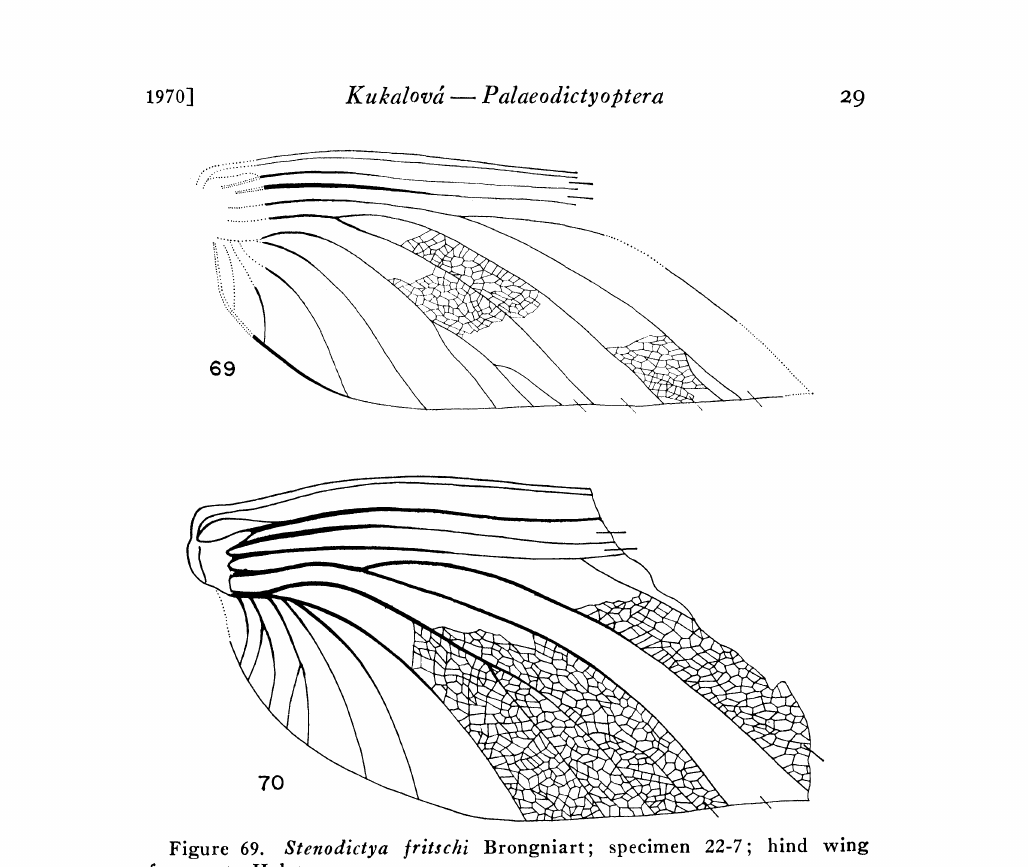
Figure 69. Stenodictya [ritschi Brongniart; specimen 22-7; hind wing fragment. Holotype. Figure 70. 8tenodictya sp. Hind